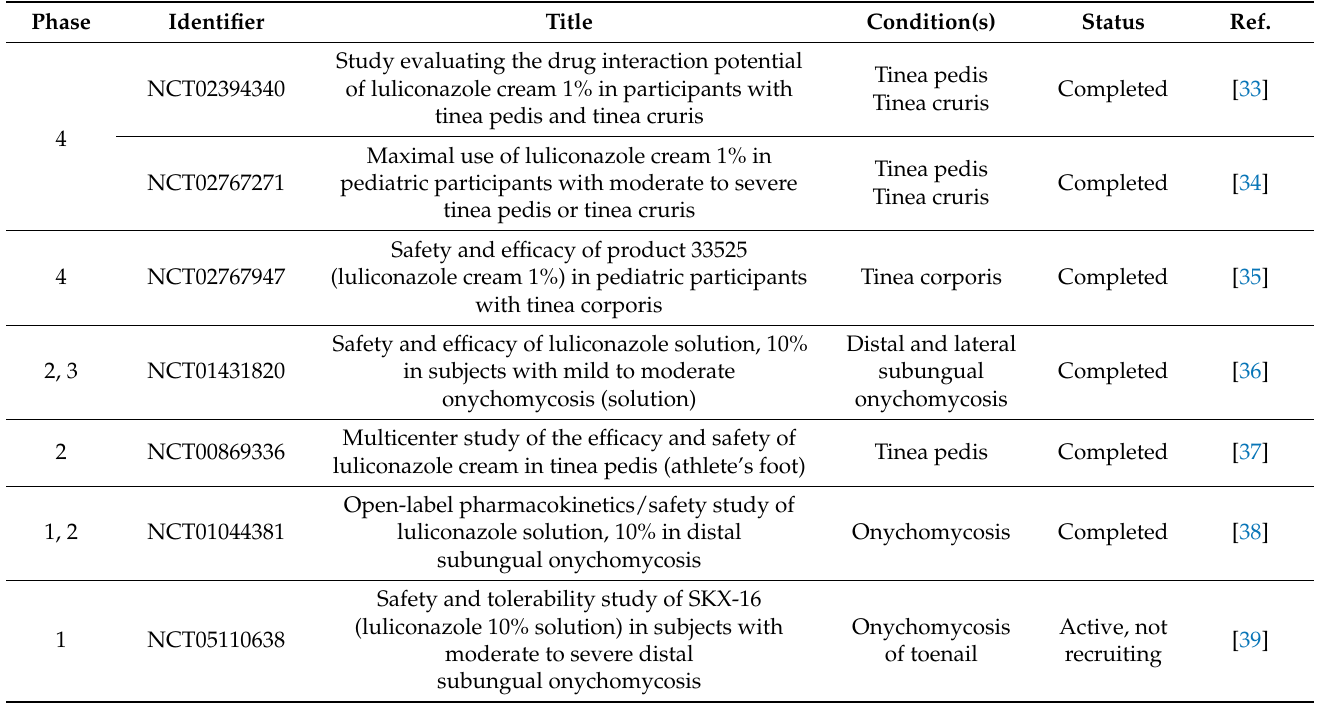
Table 1. Clinical trials for luliconazole ( 1 )